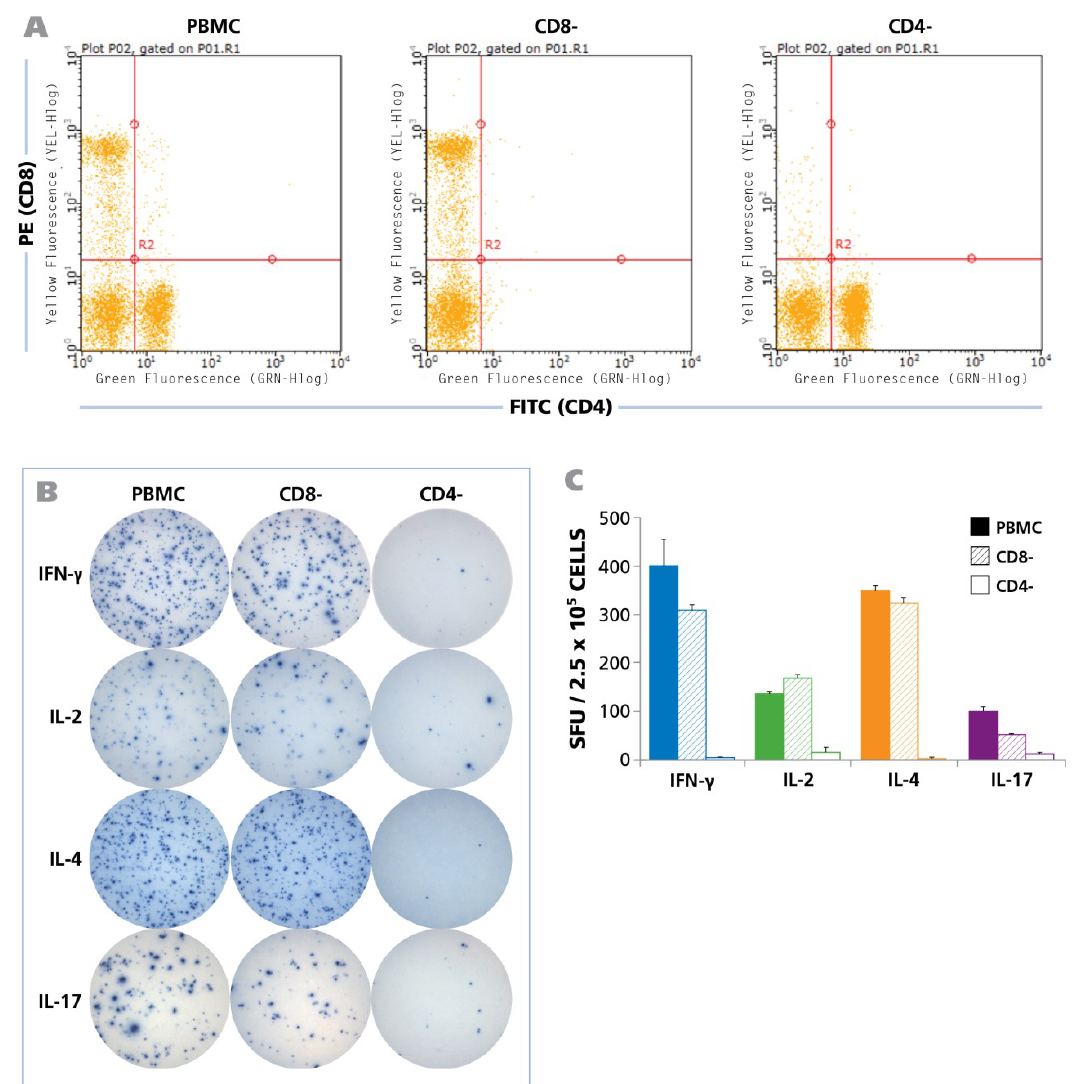
Figure 3. HCMV induced recall response is produced by CD4 cells for all cytokines. Unseparated PBMC, CD8 depleted PBMC, and CD4 depleted PBMC (2.5 × 10 5 cells each) were tested in human ELISPOT assays to detect the secretion of IFN-γ, IL-2, IL-4, and IL-17 at their appropriate time points as described in Figure 1. CD4 and CD8 depletions were carried out by magnetic bead separations. ( A ) FACS analysis of the unseparated, CD8-depleted and CD4-depleted PBMC populations is shown; ( B ) Representative well images from one donor for the unseparated PBMC, CD8-depleted PBMC, and CD4-depleted PBMC with IFN-γ, IL-2, IL-4, and IL-17 recall responses, following activation with HCMV antigen for 24 h, 24 h, 48 h, and 72 h respectively is shown; ( C ) The mean and SD (Standard deviation) of cytokine spot forming units (SFU) from 2.5 × 10 5 unseparated PBMC (shown as solid bars), CD8-depleted PBMC (hatched bars), and CD4-depleted PBMC (empty bars) each are shown (n = 6).